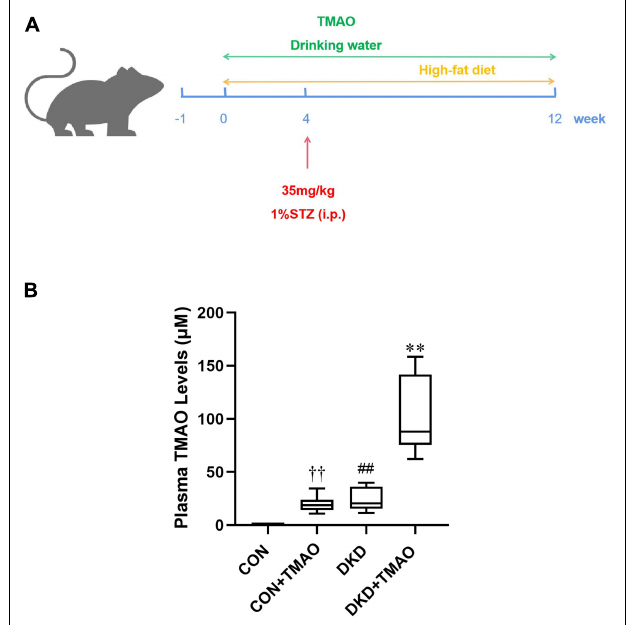
FIGURE 1 | Plasma TMAO concentration in rats. (A) Schedule of 12-week experiment. The rats received streptozotocin (STZ) or citrate buffer by intraperitoneally (i.p.) at 4th week. Moreover, rats were treated with normal diet or high-fat-diet, with or without TMAO (0.2%) in drinking water. (B) Plasma TMAO levels in rats. Data are presented as mean ± SEM ( n = 8 for each group). †† P < 0.01 vs. CON, ## P < 0.01 vs. CON, ∗∗ P < 0.01 vs.